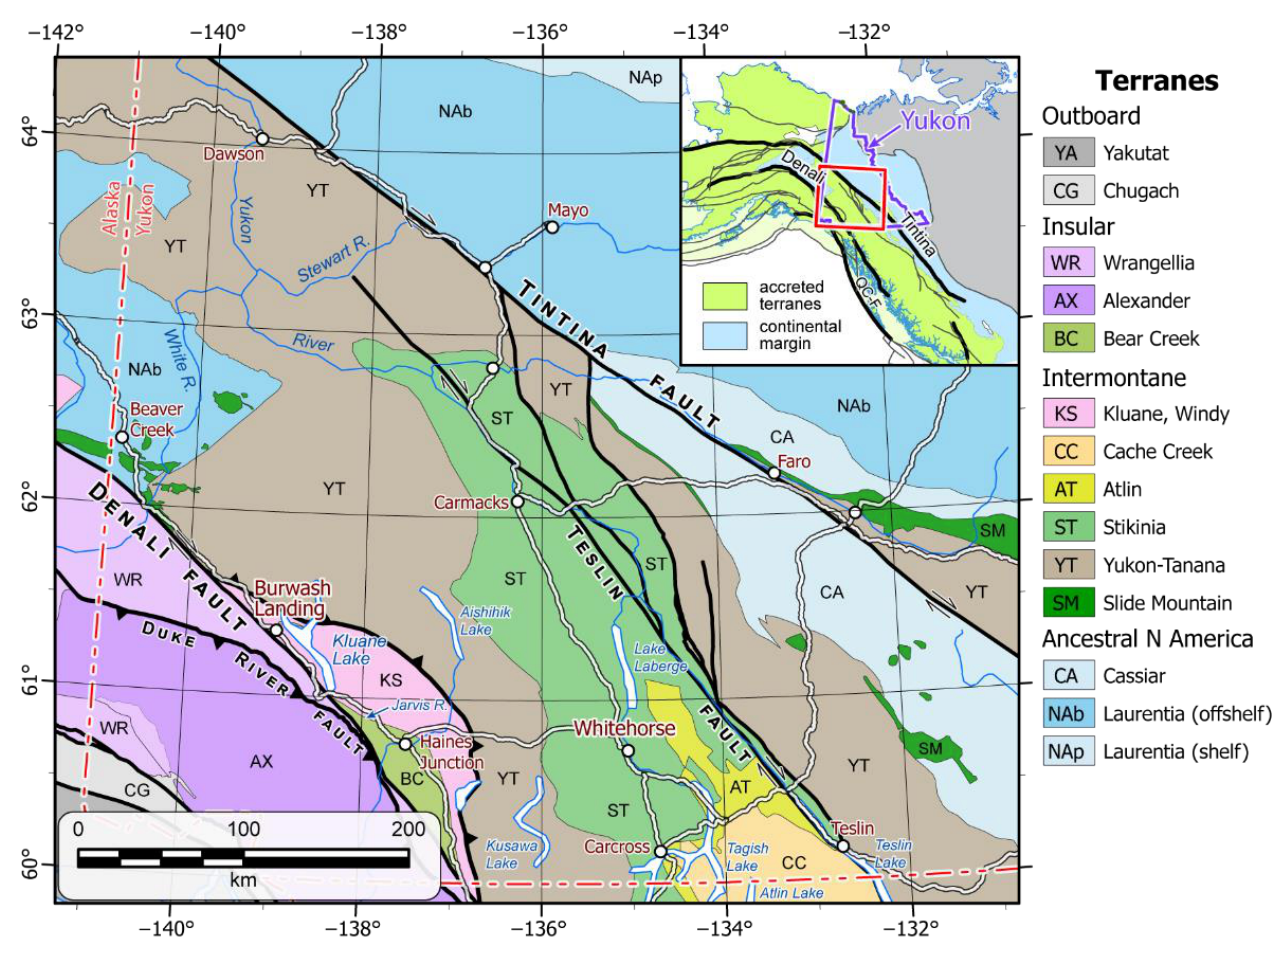
Figure 1. Terrane map of southwest Yukon showing location of the Denali fault and Burwash Landing (modified with permission from Ref. [7] © 2022, Government of Yukon). Inset shows location of southwest Yukon area in the northern Cordillera.